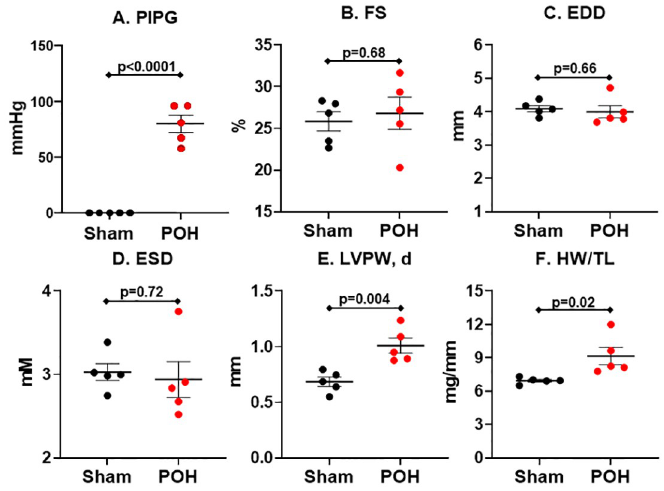
Fig 1. Echocardiogram and morphometrics in pressure-overload hypertrophy (POH) and sham (Sham) groups. Bars indicate mean ± standard error of the mean. PIPG, peak instantaneous pressure gradient across the transverse aortic constriction site; FS, left ventricular fractional shortening; EDD, left ventricular end-diastolic diameter; ESD, left ventricular end-systolic diameter; LVPW, d, left ventricular posterior wall thickness in diastole; HW/TL, heart weight normalized to tibial length; mmHg, millimeter mercury; mM, millimeter; mG, milligram. N = 5 for all groups.